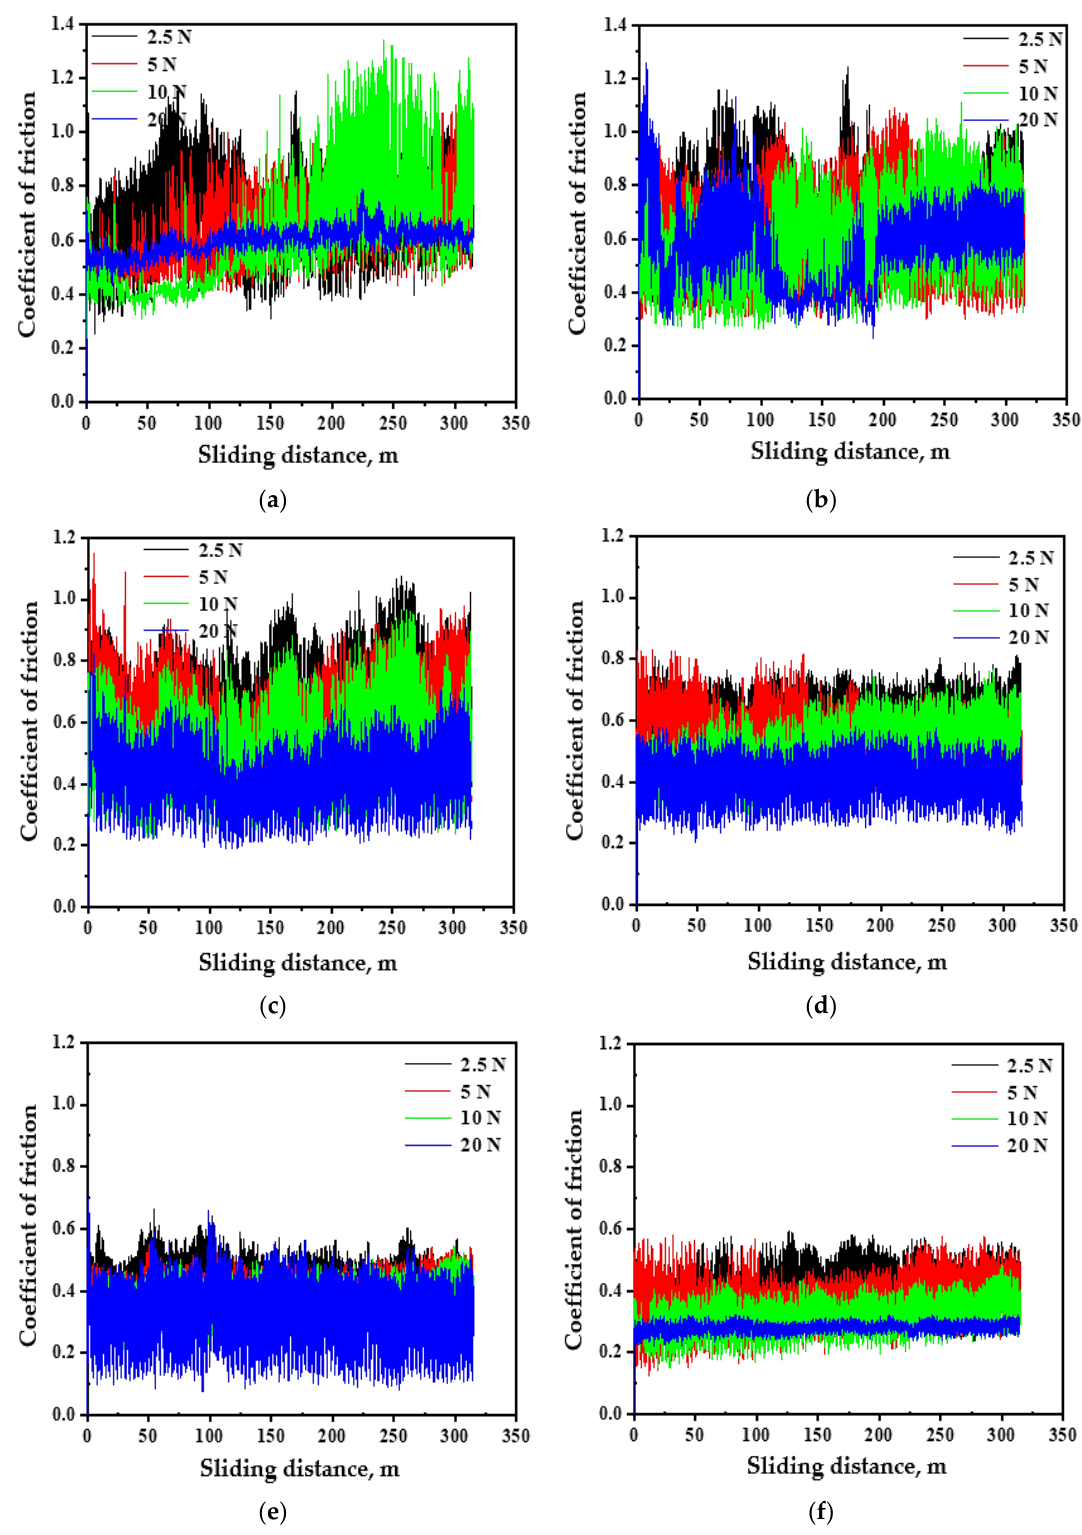
Figure 4. The COF curves of ( a ) PM Al-20% Al 2 O 3 , ( b ) PM Al-20% SiC, ( c ) HPT-processed Al-10% Al 2 O 3 , ( d ) HPT-processed Al-10% SiC, ( e ) HPT-processed Al-20% Al 2 O 3 , and ( f ) HPT-processed Al-20% SiC samples under different applied loads and a sliding distance of 315 m.